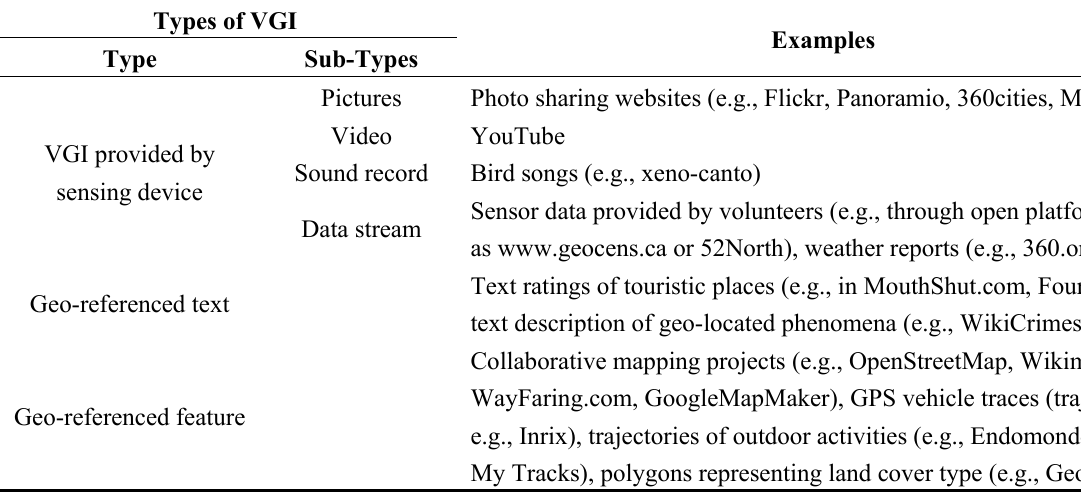
Table 1. Types of volunteered geographic information